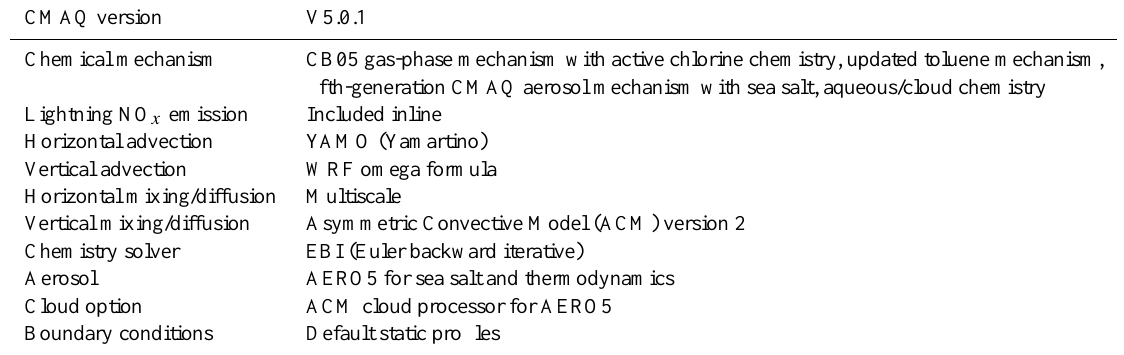
Table 2. Major CMAQ options; the text in the parentheses indicates the related settings in CMAQ build script. CMAQ